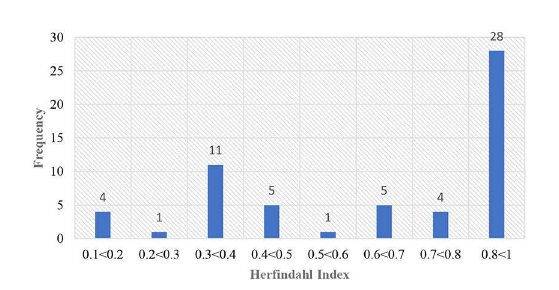
FIGURE1 Degree of diversification of crop-livestock activities in integrated crop-livestock under the CA farming system (HI, Herfindahl index). The following classification is used: if HI ≤ 0.5, this suggests diversified crop-livestock smallholders; HI > 0.8 indicates highly specialized smallholders, and HI of 0.5–0.8 indicates moderately specialized smallholders. Source: Own elaboration from field data